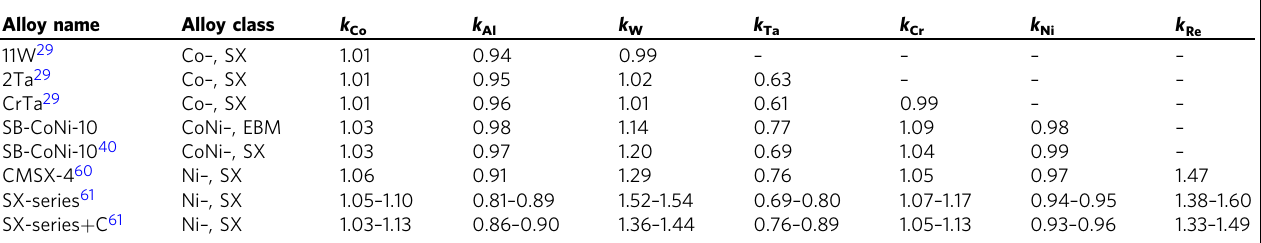
Table 1 Experimentally measured distribution coef fi cients ( k i ) using the EPMA grid